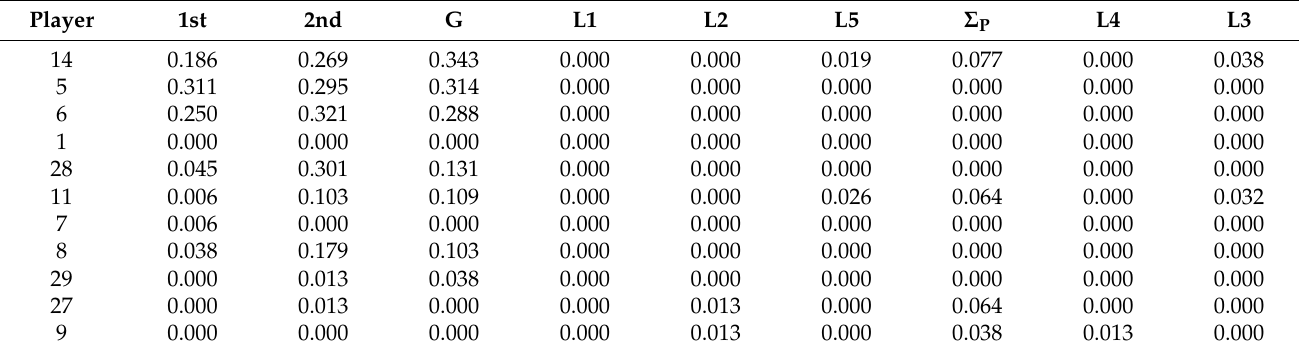
Table A6. Team B’s Betweenness Centrality Matrix of values.